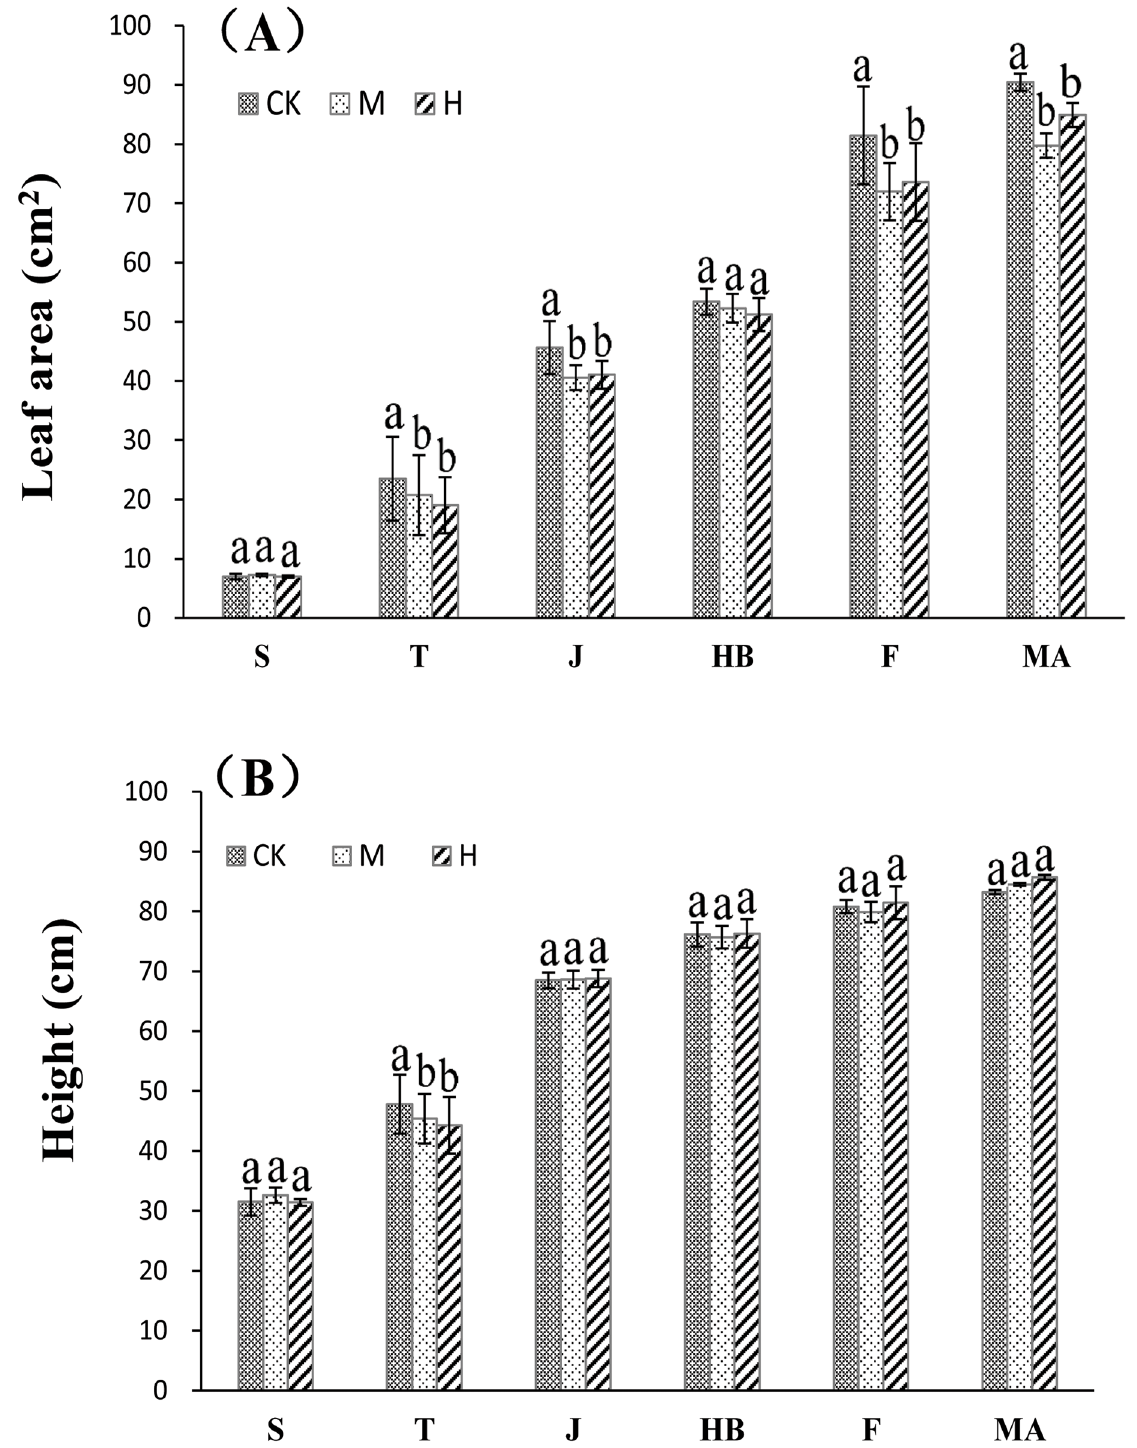
Fig 1. Effects of increased atmospheric CO 2 levels and high temperature on leaf area (A) and plant height (B). Note: S, T, J, HB, F and MA stand for the seeding, tillering,jointing,headingand blooming, as well as the filling and maturation stages, respectively;a, b and c indicate significantdifferences at the 0.05 level in the same growth stage.